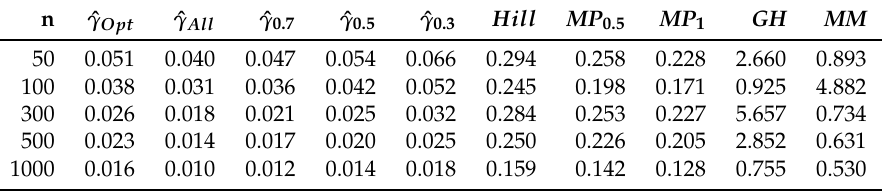
Table 1. RMSE of the estimators for the Pareto(4) distribution; 1000 Montecarlo replications.